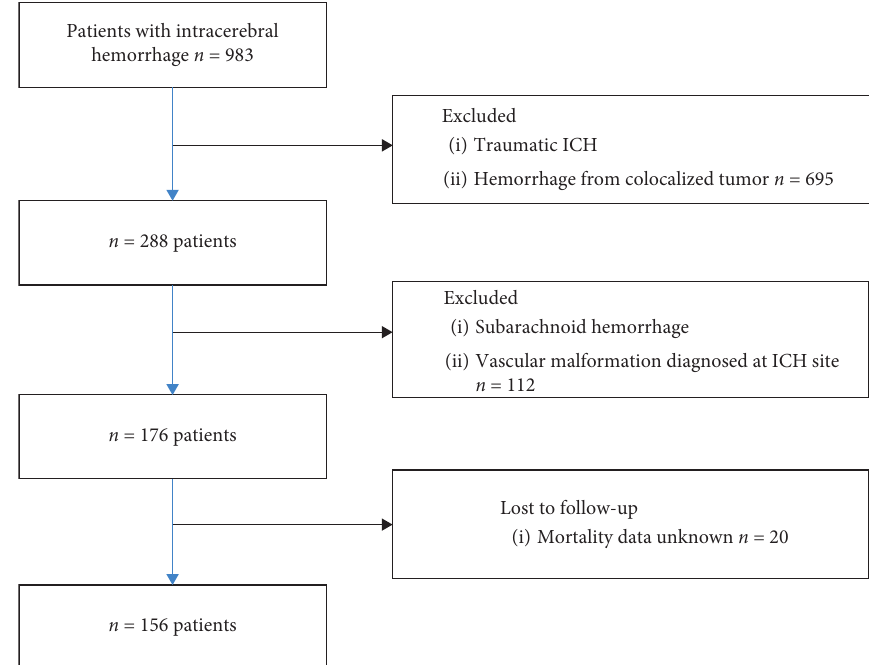
Figure 1: Flow Chart with inclusion and exclusion